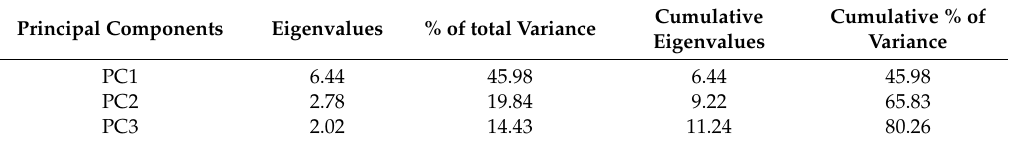
Table 10. Analysis of principal components for Baltic-type raised bog, fen, and peat-moorsh soils. % of total Principal Components Eigenvalues